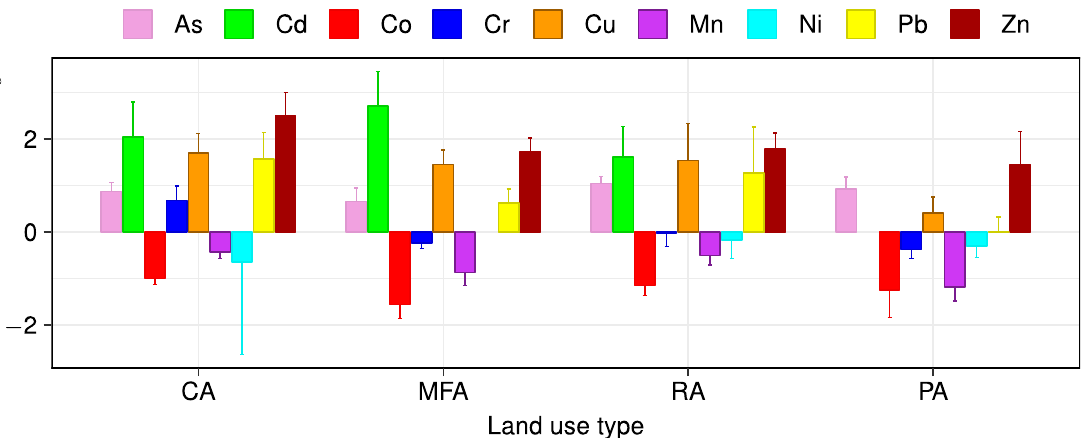
Figure 6. Geoaccumulation (Igeo) of each toxic metal (As, Cd, Co, Cr, Cu, Mn, Ni, Pb, and Zn) in the road dust of Mymensingh City. CA = commercial areas, MFA = medically facilitated areas, RA = residential areas, PA = park areas.